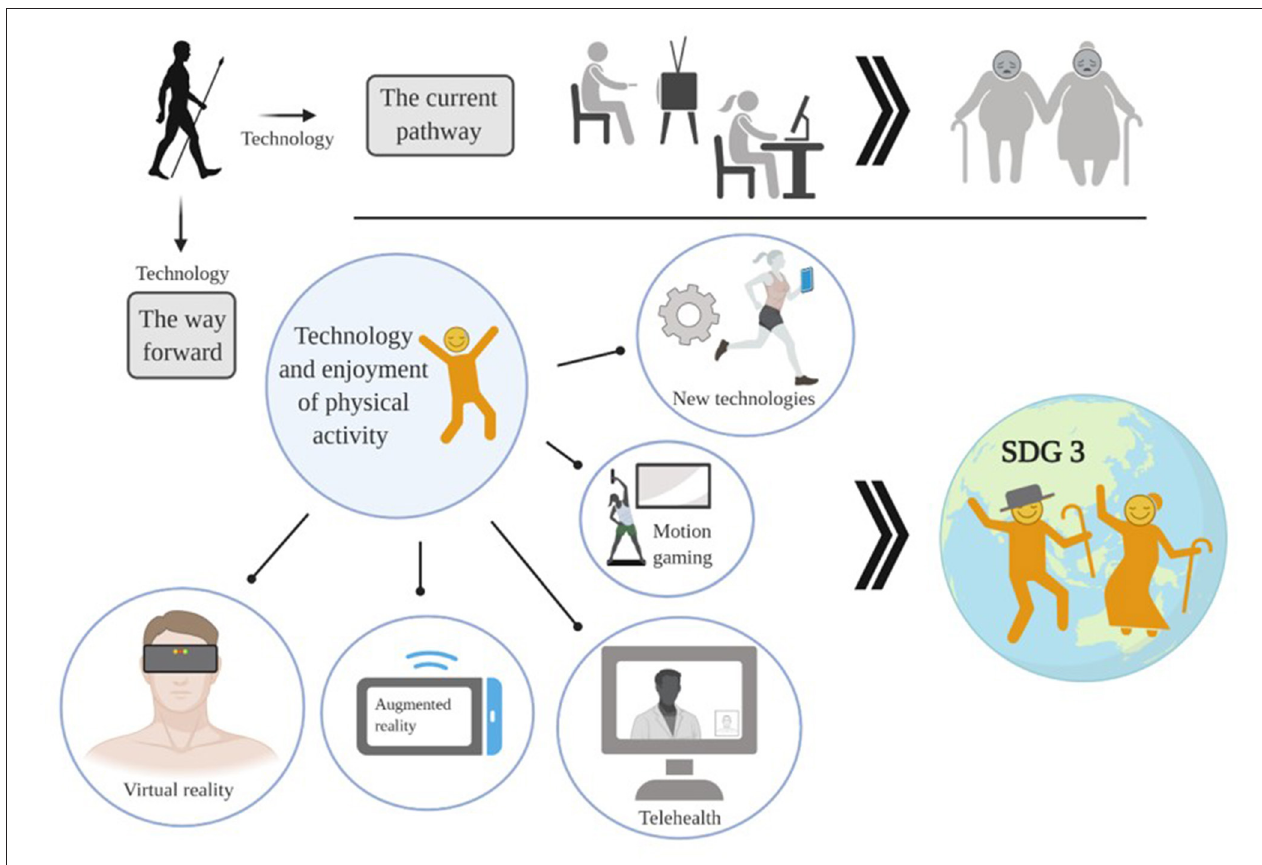
FIGURE 2 | Currently technologies promote sedentary behaviour and physical inactivity, however, technologies have the vast potential to be repurposed to promote increased engagement and enjoyment of physical activity. This will contribute to the UN SDG#3 targets and indicators, ensuring health and well-being for all. Created with